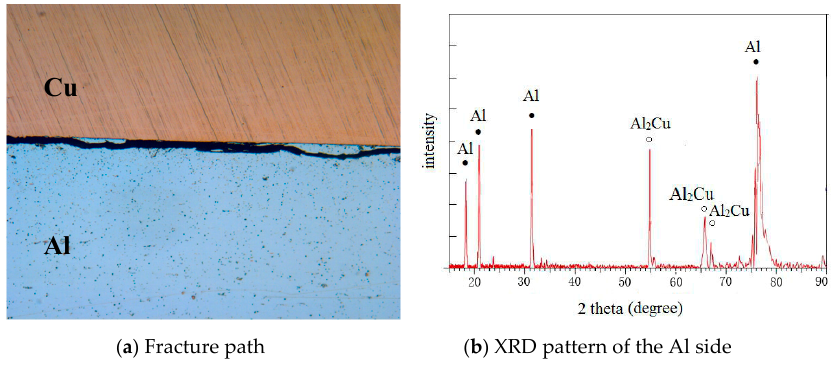
Figure 5. Fracture path and XRD pattern of the fracture surface of the joint welded with the 240 ms duration.